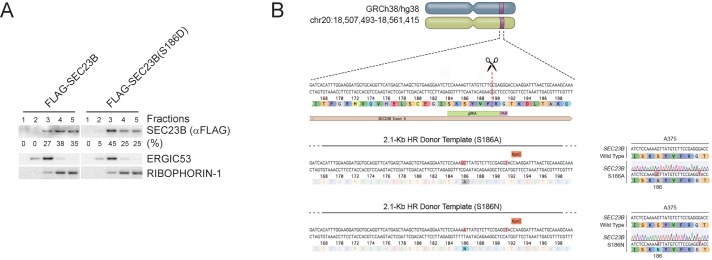
Ser186 in SEC23B is necessary for its localization to the ERGIC and an efficient autophagic response upon nutrient deprivation.(A) HeLa cells were permeabilized, incubated with either purified recombinant FLAG-tagged SEC23B or purified recombinant FLAG-tagged SEC23B(S186D), and subjected to subcellular fractionation. Each fraction was subjected to immunoblotting with the indicated antibodies. ERGIC53 was used as a marker of the ERGIC, and RIBOPHORIN-1 as a marker of the ER. SEC23B bands were subjected to densitometry analysis and quantified as percentage of total SEC23B or SEC23B(S186D). (B) Schematic representation of the SEC23B genomic locus and gRNA target location. Exon five refers to human SEC23B gene (Gene ID: 10483). Wild-type genomic DNA template and knock-in mutant sequences are shown for both SEC23B(S186A) and SEC23B(S186N).